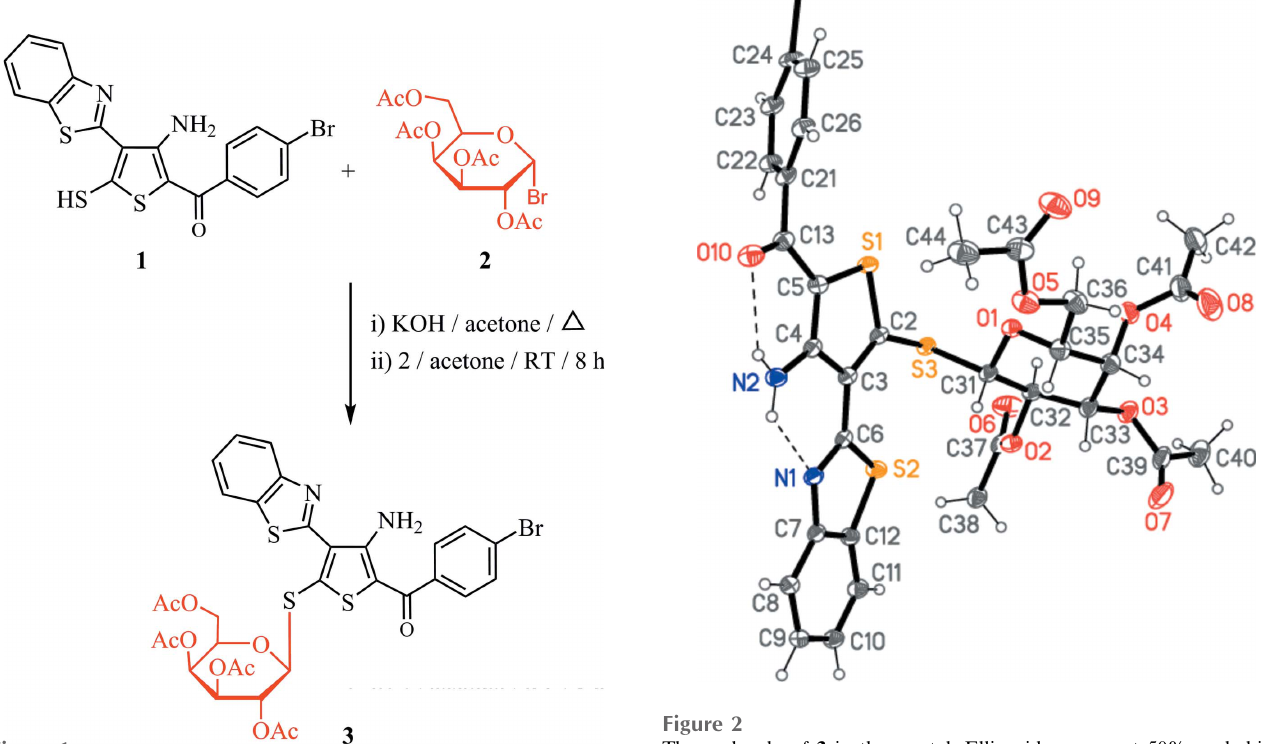
Figure 1 Reaction